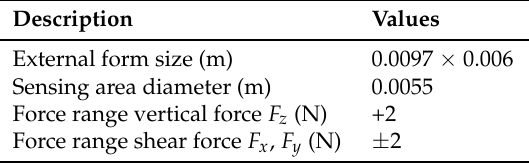
Table 2. Tactile sensor: Shokac Chip SP.